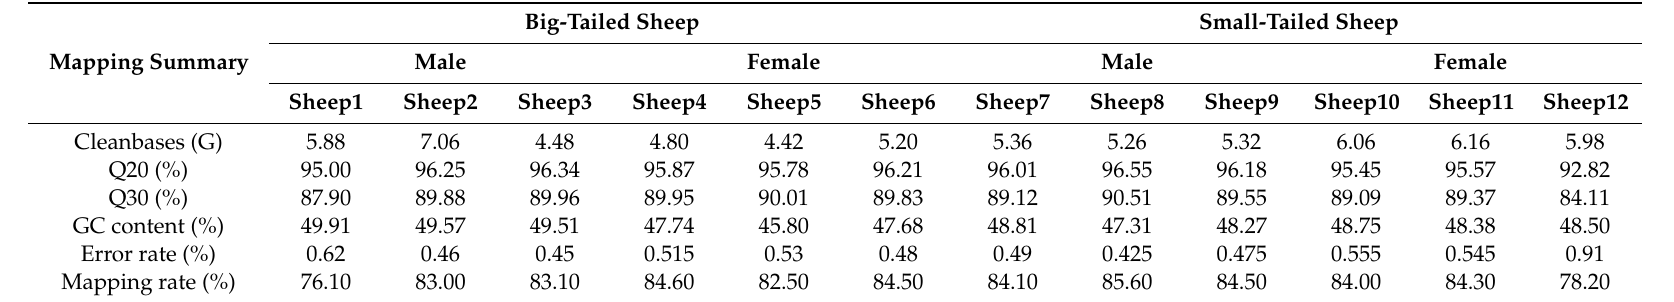
Table 2. The basic statistics for RNA-seq reads generated from tail fats of Hulun Buir